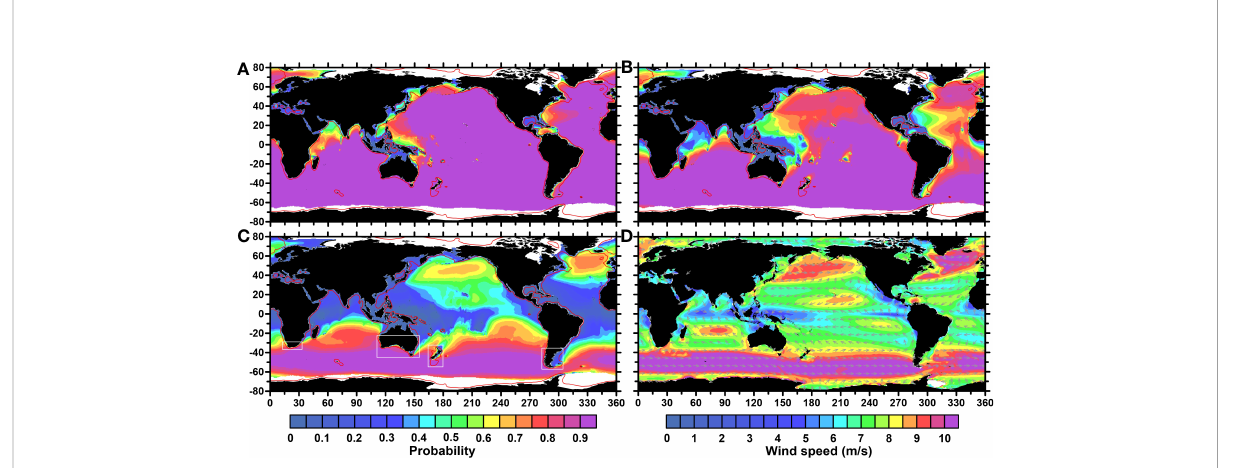
FIGURE 8 Distributions of the daily wave power and wind speed per 0.5° × 0.5° cell. Probabilities for wave power values great than (A) 5, (B) 10, and (C) 20 kW/m. (D) Averaged wind speeds. The red lines denote water depths contours of 1000 m, while the white rectangles mark regions with high wave power harvesting